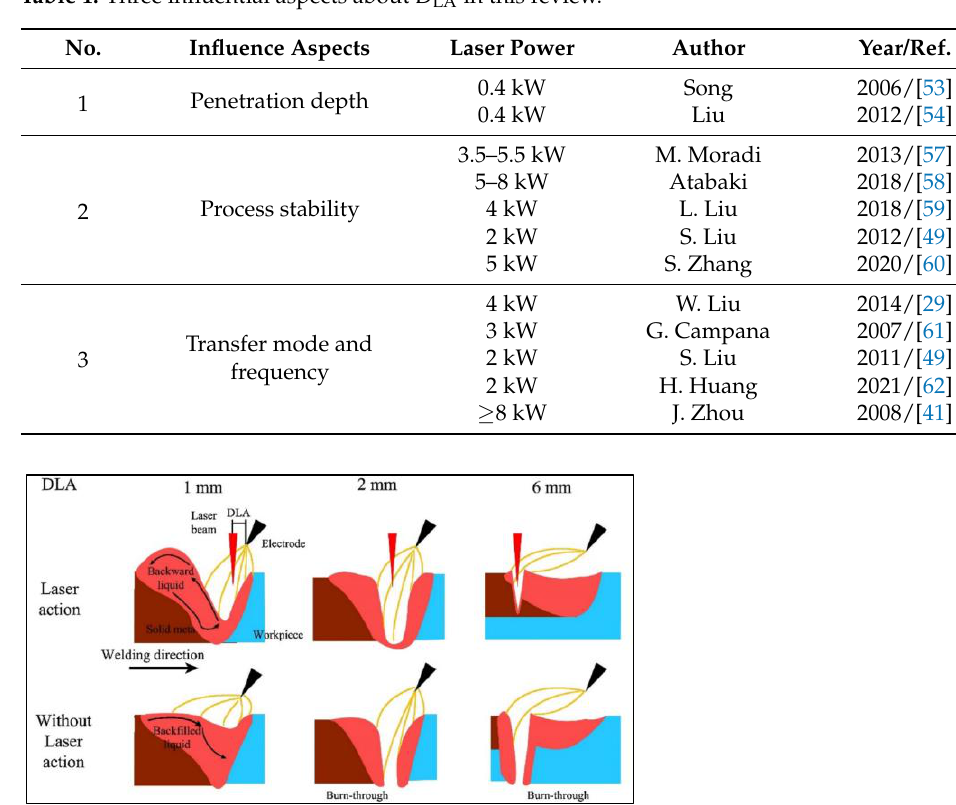
Figure 9. The schematic diagram of the burn-through [59]. Reprinted with permission from [59] 2018 Elsevier.